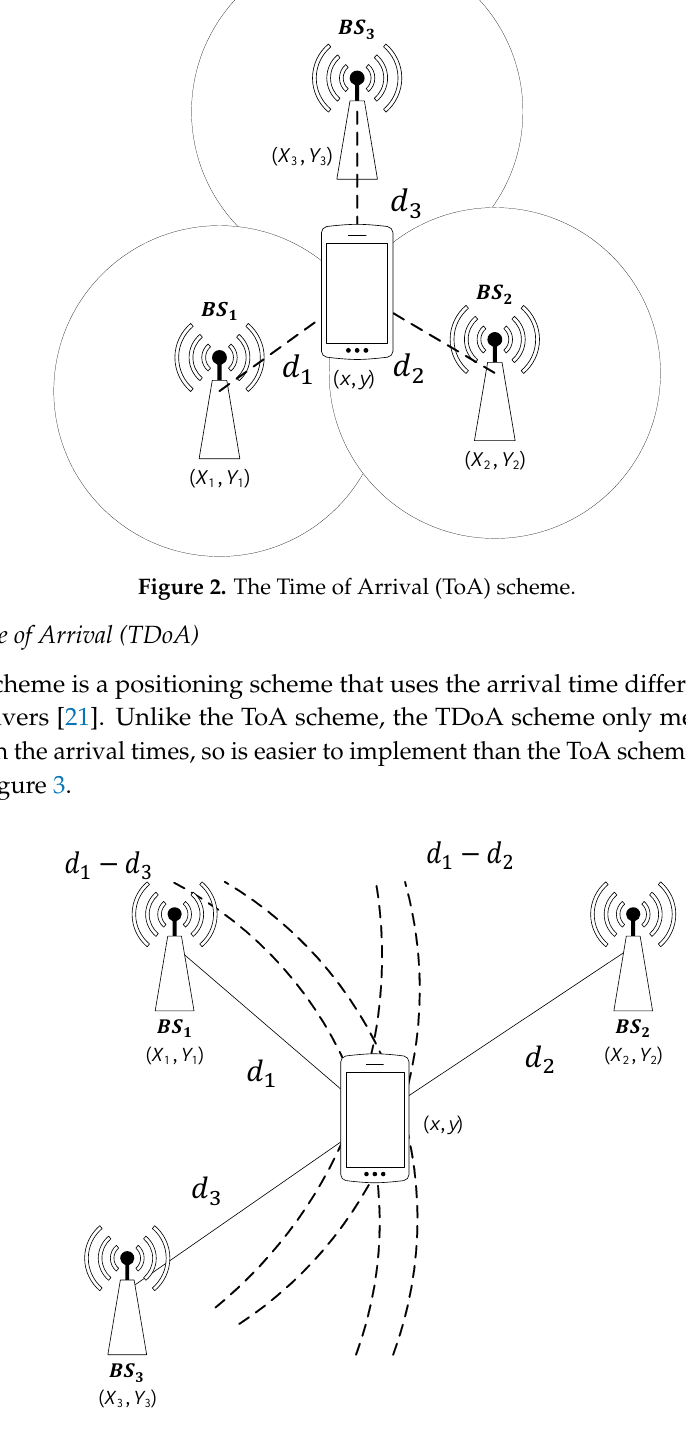
Figure 3. The Time Difference of Arrival (TDoA)